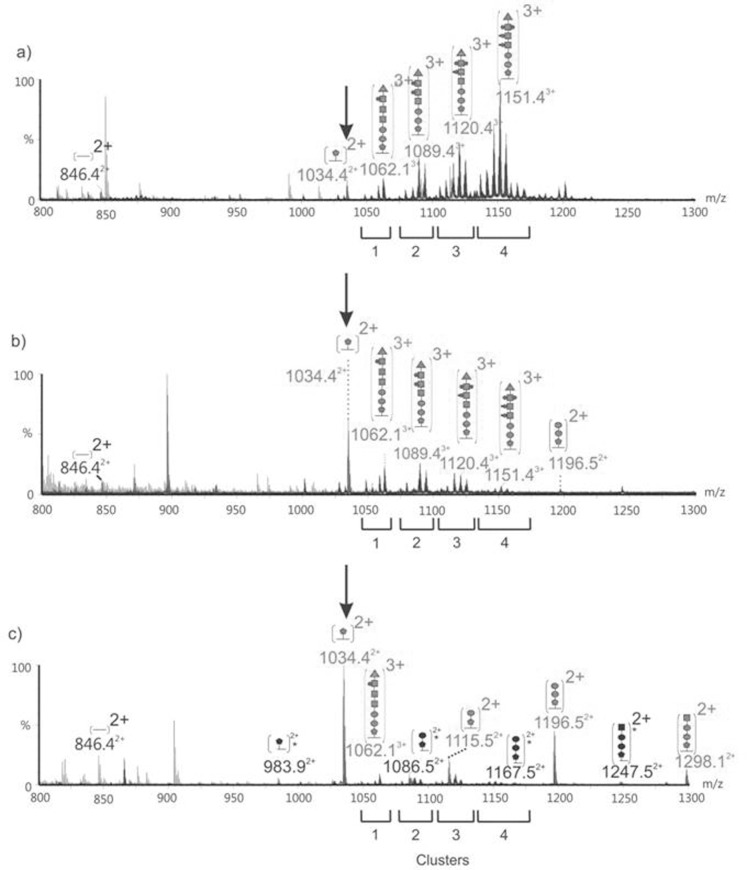
nLC-MS alignment of the AH-3 polar flagellin FlaA/FlaB glycopeptide.The 1691 Da FlaA/FlaB peptide TLAQQSANGSNNTDDR (eluting between 13.1 and 13.8 minutes) was modified by a heptasaccharide glycan with HexNAc residues additionally variably modified by 0–2 phosphate and 0–2 methyl groups [9]. These additional variable modifications resulted in four major glycopeptide ion cluster regions, as indicated below each spectrum. The cluster number corresponds to the number of additional phosphate groups modifying the heptasaccharide, and peaks within that cluster possess a variable number of additional methyl groups. Only the most prominent peak within each cluster is annotated. a) Wild type polar flagellin. Glycoforms of the peptide modified with the heptasaccharide were more abundant, compared with the peptide modified with only a single 376 Da (this form of the glycopeptide is indicated in the Figure with an arrow at m/z 1034.4). The glycopeptide peak intensity increased with the addition of each phosphate group. b) AH-3ΔWecP mutant polar flagellin. In contrast to wild type, the predominant modification in AH-3ΔwecP was a single 376 Da sugar. The glycopeptide clusters resulting from the heptasaccharide glycan and additional variable modification were observed, but with decreased intensity as compared to the monosaccharide modification. c) AH-2767 (gne mutant) polar flagellin. A decrease in the complexity of glycan modification was observed. The most abundant modification observed was the single 376 Da glycan. Glycopetpide clusters were not observed in the same manner when compared to wild type and the longer chain modifying glycans were not observed. In addition, the unmodified peptide was also observed at m/z 846.42+. This was not detectable in wild type, Figure legend: solid pentagon = 376 Da sugar; • = hexose; ▪ = HexNAc; ▴ = 102 Da unknown moiety; • = phosphorylation; ▪ = methylation; * = truncated peptide.